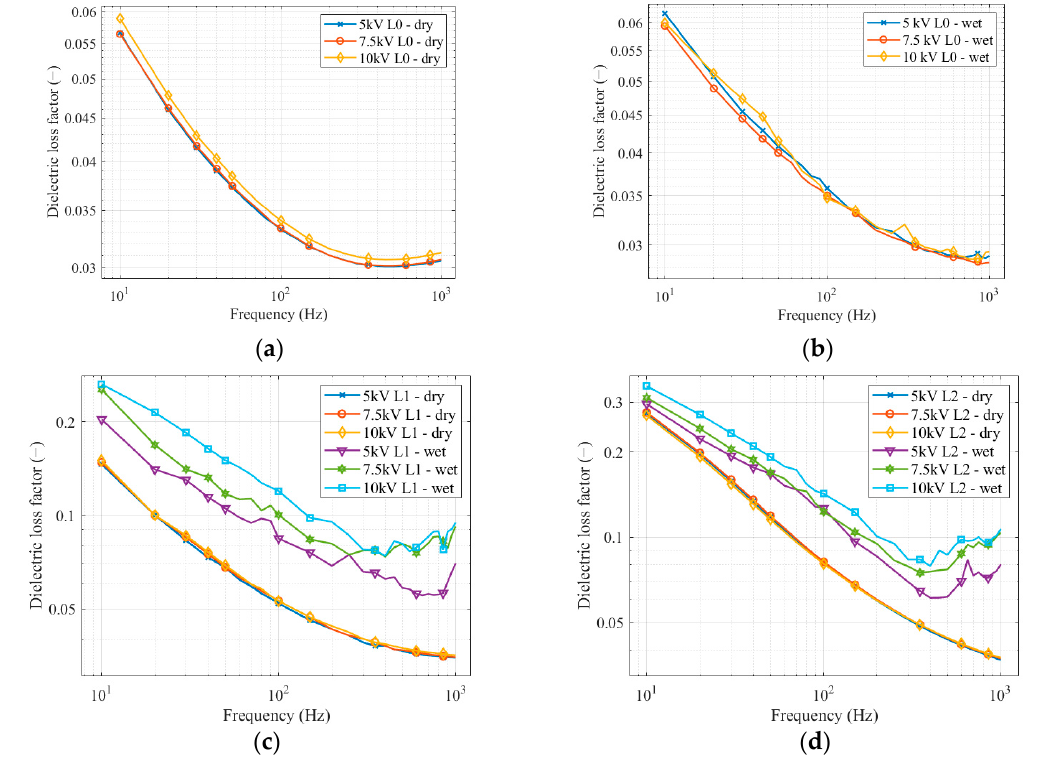
Figure 6. Dielectric loss factor frequency spectrum for different voltage levels: ( a ) clean insulator (dry); ( b ) clean insulator (wet); ( c ) first pollution level; ( d ) second pollution level.